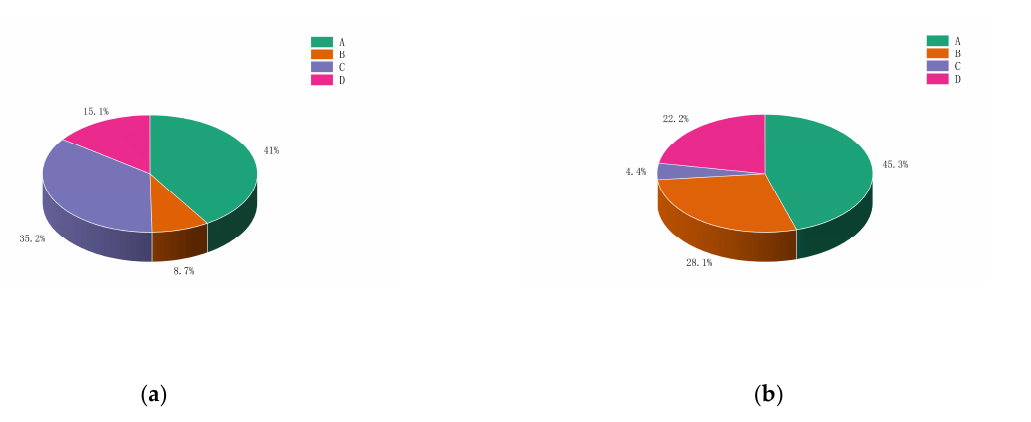
Figure 5. Proportions of various types in Beijing ( a ) and Shanghai ( b ). Table 4. Hourly variation coefficient of dry bulb temperature in Beijing.